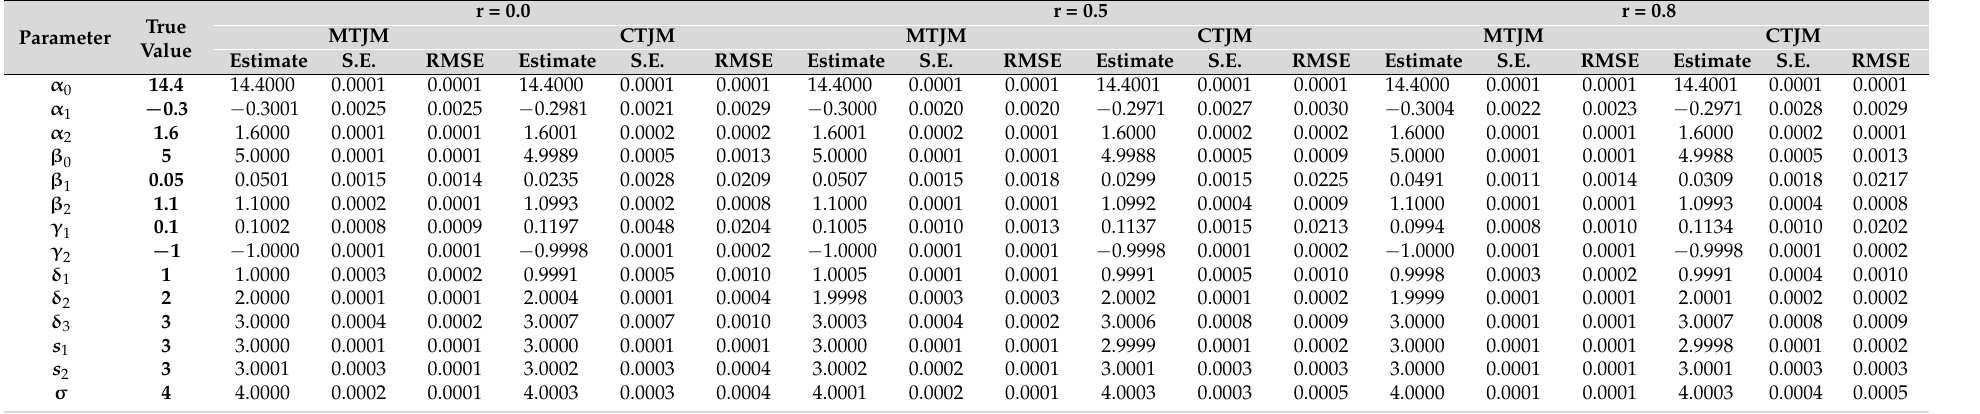
Table 3. Simulation results for MTJM and CTJM under n =